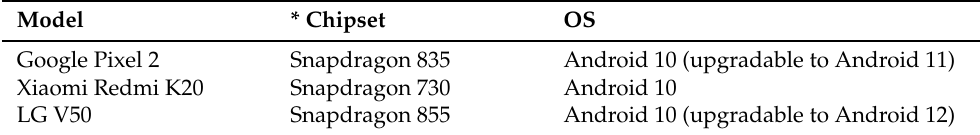
Table 1. Specifications of the selected smartphones. Model * Chipset OS Google Pixel